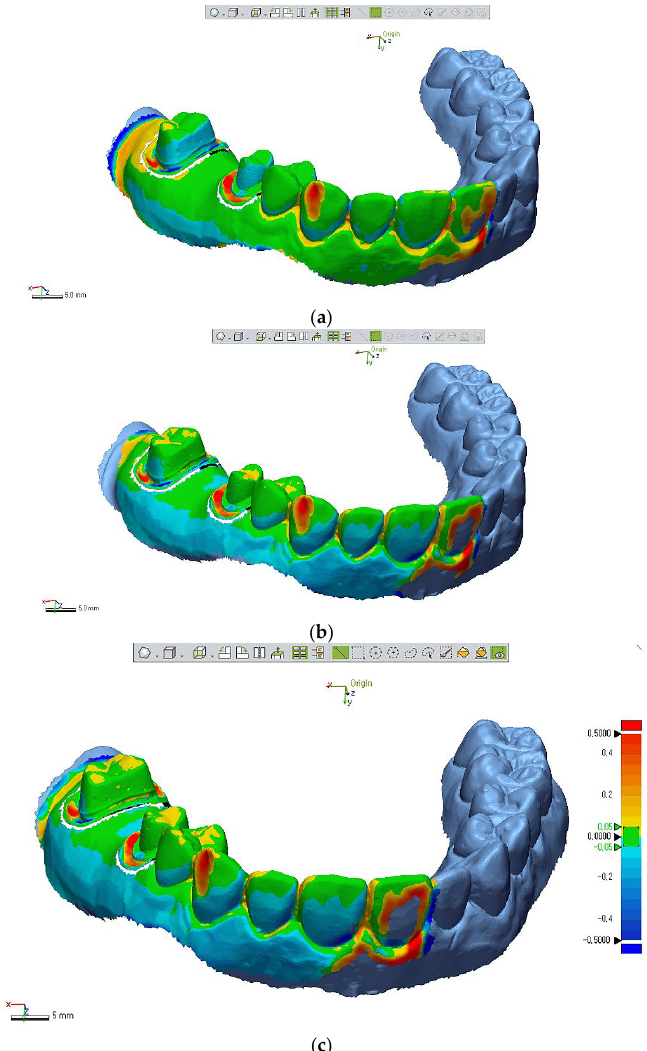
Figure 4. Color maps of 3D model superimpositions of each printed test model STL file with the original reference file. Table 50. μm expressing green colors, and max/min critical range at ±500 μm representing dark red or blue colors. The Scheme 0. to 0.5 mm. ( a ) DLP cast. ( b ) MJP cast. ( c ) SLA cast.